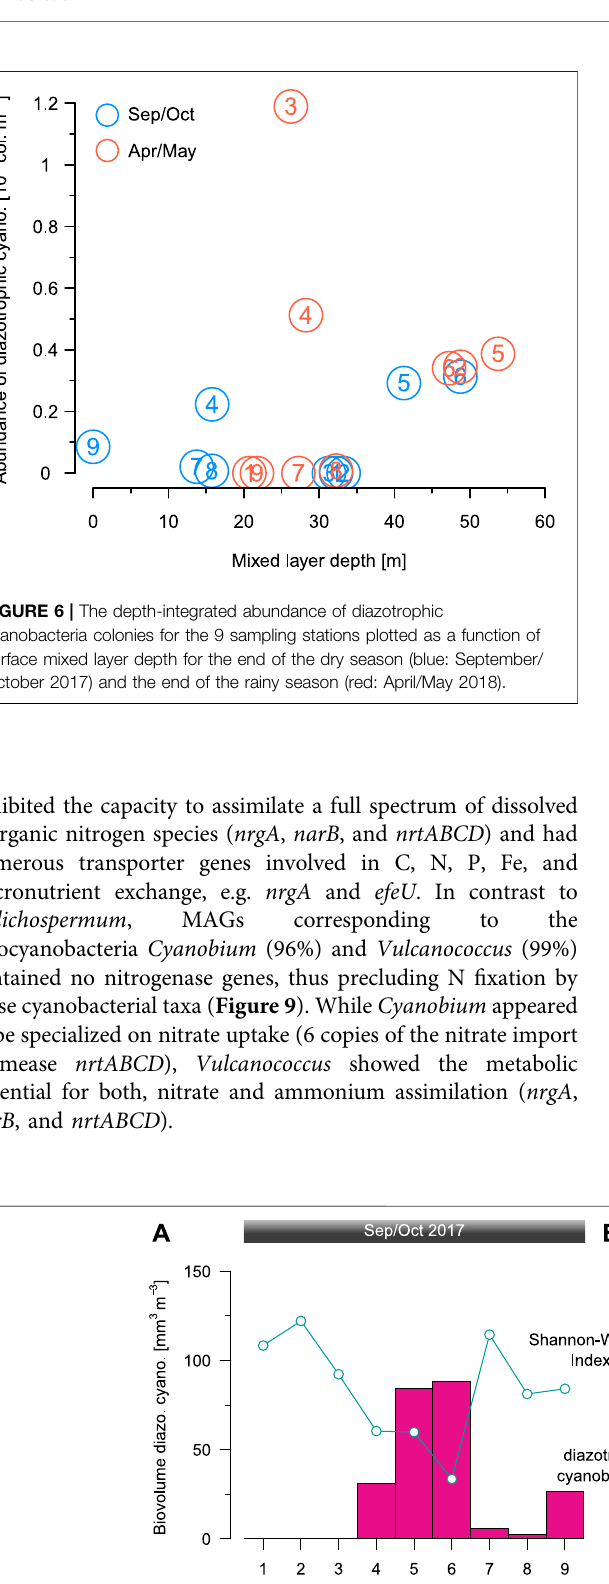
Frontiers in Environmental Science |